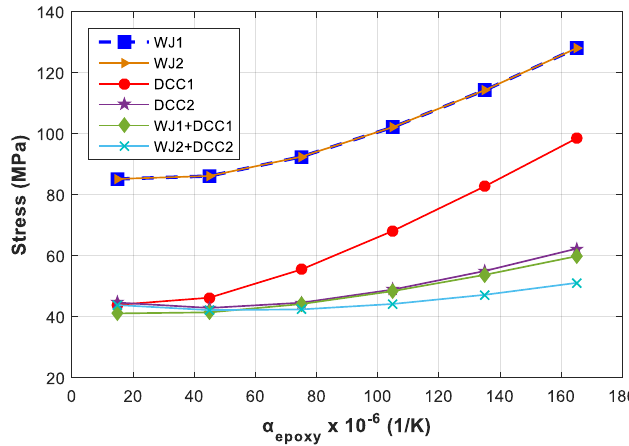
Figure 13. Average stress in the copper wires as a function of the coefficient of thermal expansion of epoxy.